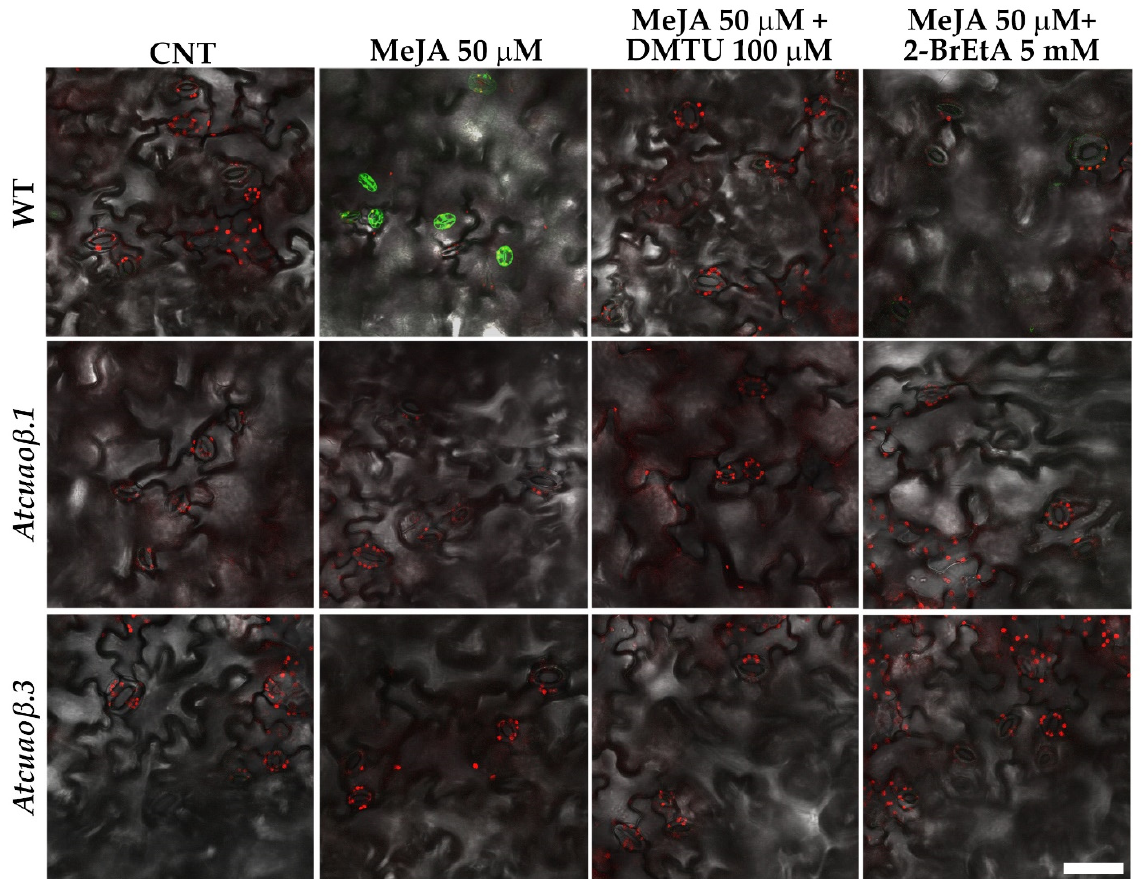
Figure 7. ROS levels in guard cells of cotyledonary leaves from seven-day-old seedling. In situ, ROS detection by LSCM analysis after CM-H 2 DCFDA staining of cotyledonary leaves from WT, Atcuao β .1 and Atcuao β .3 mutant seedlings, untreated or treated with 50 µ M MeJA, either alone or in combination with 100 µ M DMTU or 5 mM 2-BrEtA. Micrographs are representative of those obtained from five independent experiments, each time analysing cotyledonary leaves from five seedlings per genotype and treatment. Bar = 50 μ m.